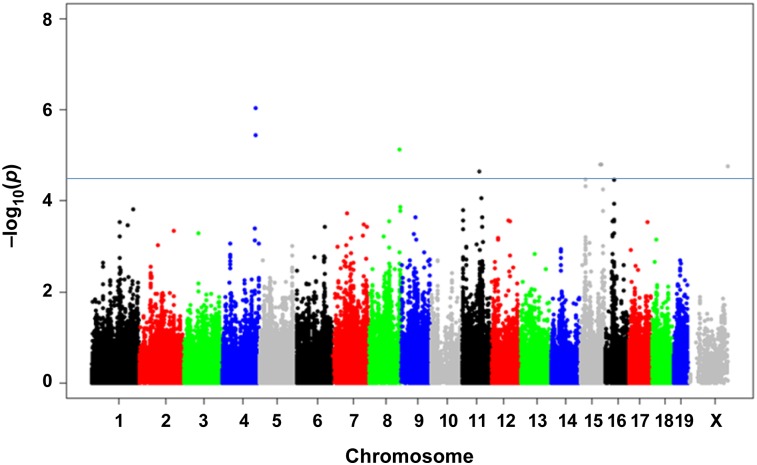
GWAS results for vessel area using EMMA.Manhattan plot showing the EMMA adjusted association (-log10) p-values (-logP) for vessel area in 42 common inbred mouse strains. The analysis was performed using 132k SNPs with a minor allele frequency > 5%. Each chromosome is plotted on the x-axis. SNPs on Chr. 4 (rs32857122; p = 9.34 x 10−7 and rs32259427; 3.67 x 10−6) show GWAS peaks with highest significance.